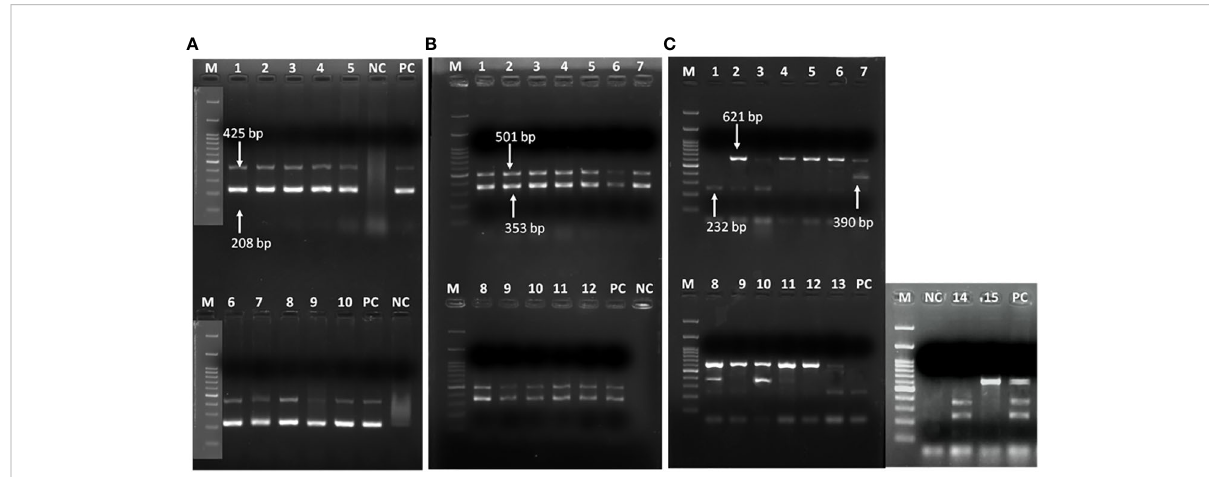
FIGURE 2 Representative gel image showing (A) recA and ITS genes in A baumannii ; (B) bla OXA-51 and bla OXA-23 genes; (C) multiple class B carbapenemases. (A) Lane M: Marker 100 bp; Lane 1-5,6-10: recA (425bp) & ITS gene (208bp); NC: negative control PCR-grade water; PC: positive control A. baumannii ATCC 19606. (B) class D carbapenemase genes; Lane M: Marker 100 bp; Lane 1-12: bla OXA-51 (353 bp) & Lane 1- 12: bla OXA-23 (501 bp); NC: negative control PCR-grade water; PC: previously con fi rmed & published isolate positive for bla OXA-51 & bla OXA-23 genes (C) class B carbapenamse genes; Lane M: Marker 100 bp; Lane 1-3,6,8, 13, 14: bla IMP (232 bp), Lane 7-8,10-11, 14: bla IMP (390 bp) & Lane 2-13, 15: bla NDM (621 bp); PC: previously con fi rmed & published isolate positive for bla IMP , bla VIM and bla NDM